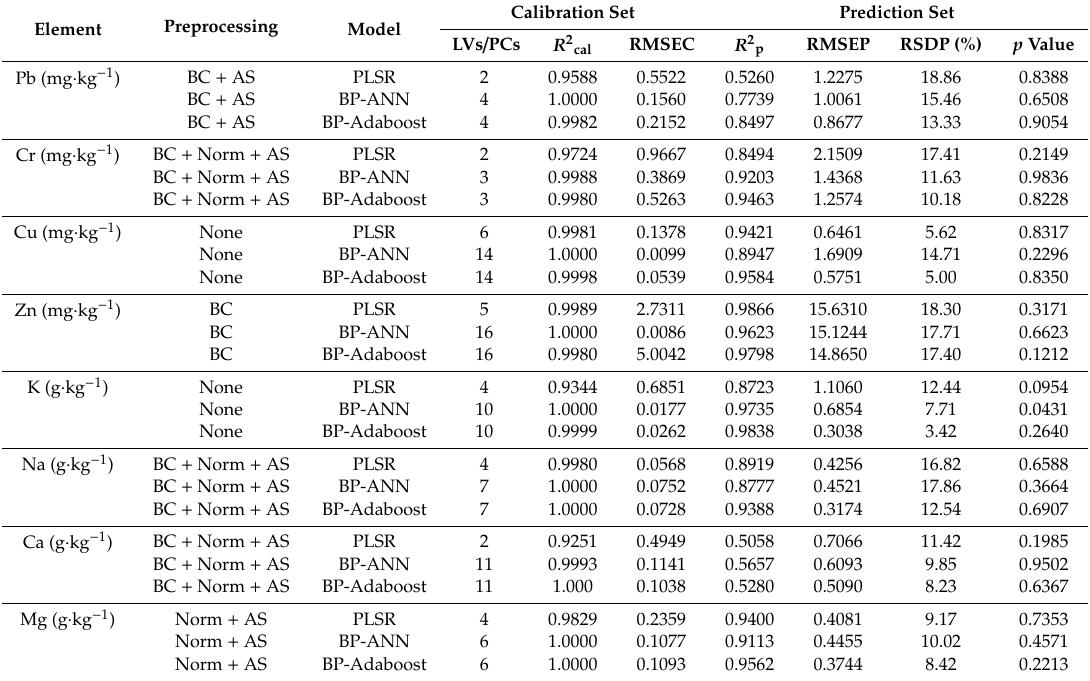
Table 4. Model results of multivariate partial least squares regression (PLSR), backpropagation artificial neural network (BP-ANN), and BP-Adaboost.